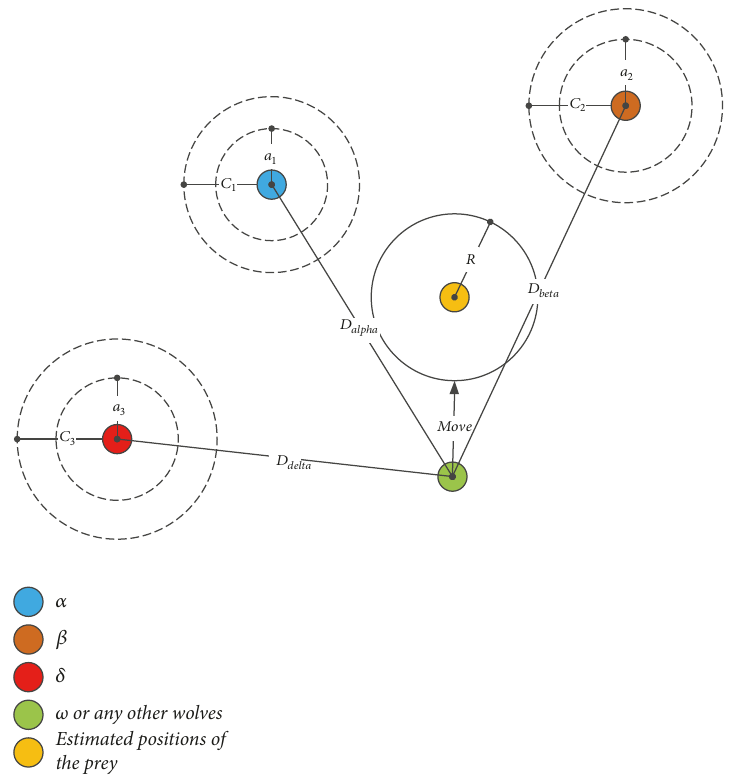
Figure 1: The position update process in GWO